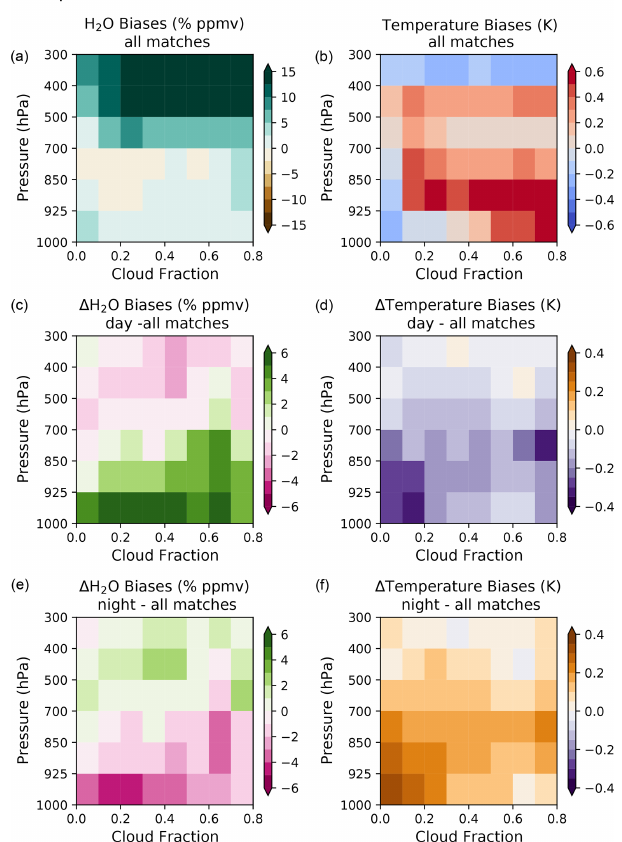
Figure 8. IMS water vapour (a, c, e) and temperature (b, d, f) pro- file biases as a function of cloud fraction for all sites, calculated for 10% cloud faction bins for each tropospheric pressure layer. Dif- ferences between daytime and night-time biases and the bias for all sites are shown for water vapour and temperature, respectively.